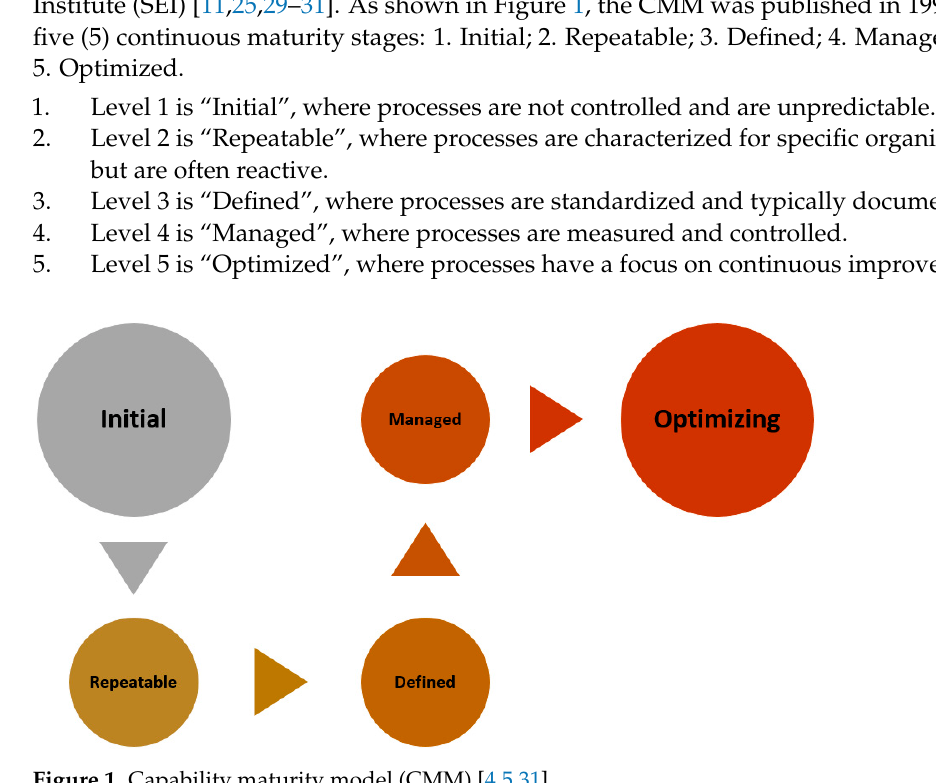
Figure 1. Capability maturity model (CMM) [4,5,31].